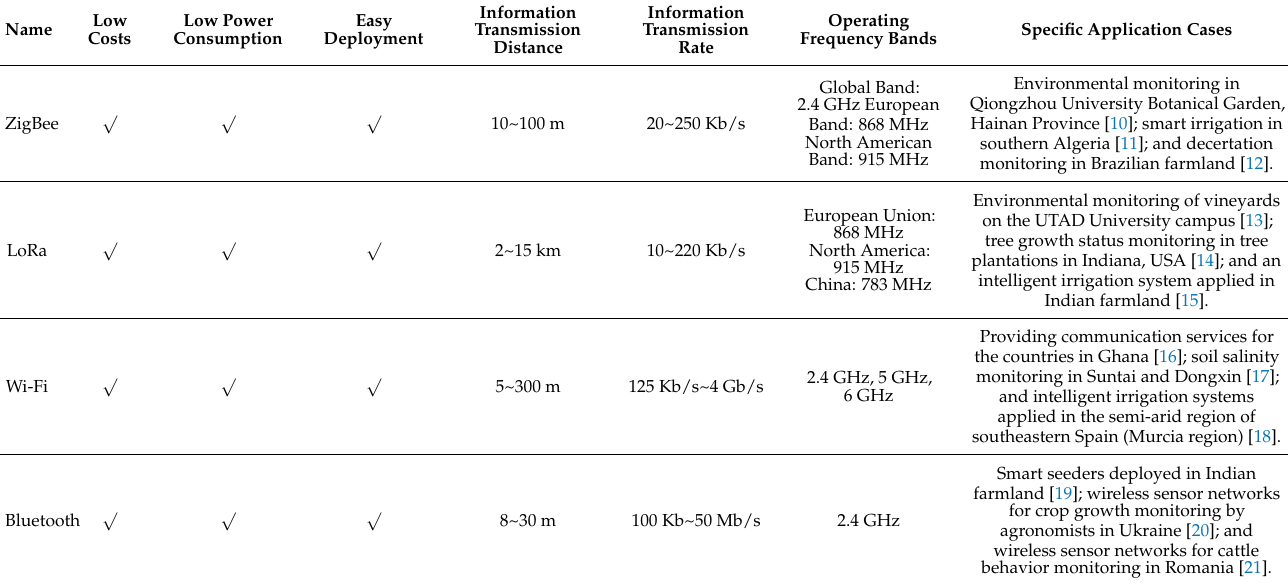
Table 2. Mature wireless communication technologies in